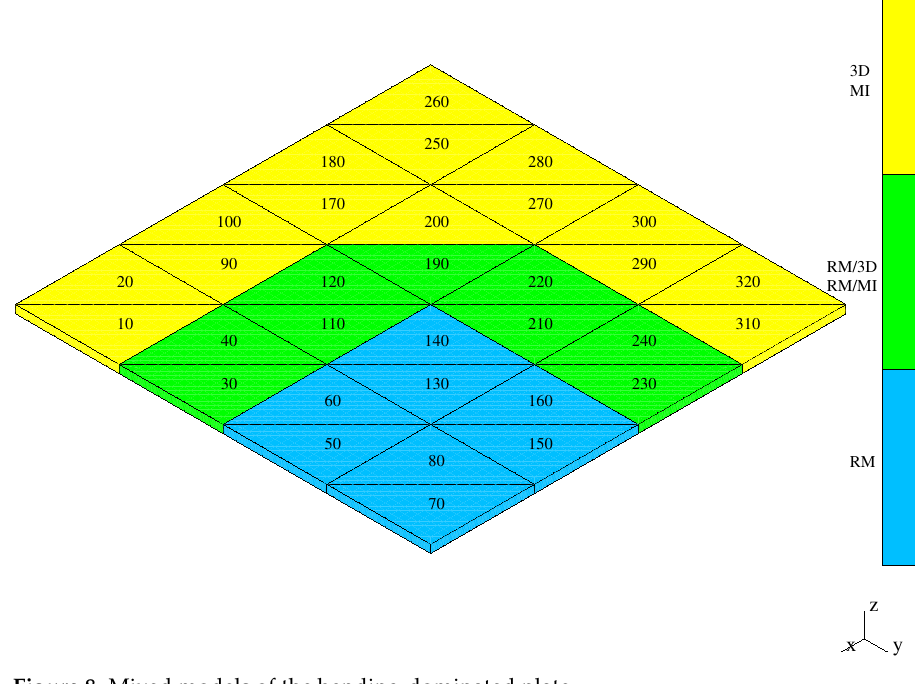
Figure 8. Mixed models of the bending-dominated